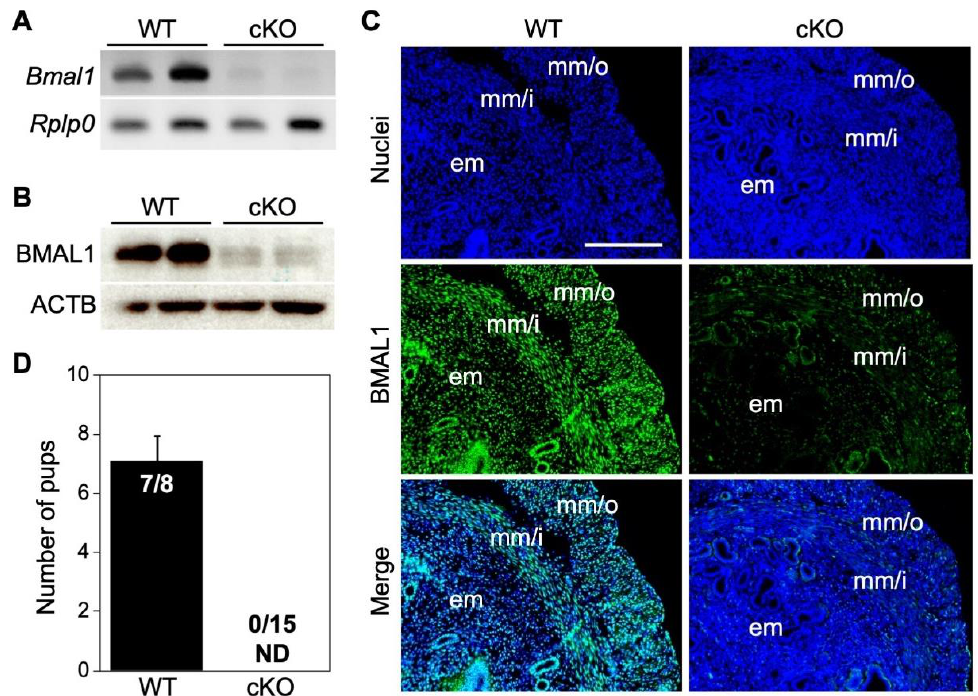
Figure 1. Bmal1 cKO uteri showed efficient deletion of BMAL1 and no live birth. ( A – C ) The uterine deletion of BMAL1 was observed by ( A ) RT-PCR, ( B ) Western blotting, and ( C ) immunofluores- cence. ( D ) Uterine Bmal1 cKO mice showed no live births. The bar shows SE. ACTB, ACTIN; em, endometrium; mm/i, inner circular layer of myometrium; mm/o, the outer longitudinal layer of myometrium; ND, not determined. The scale bar shows 200 µ m. Table 1. cKO mice start to fail pregnancy maintenance after day six of